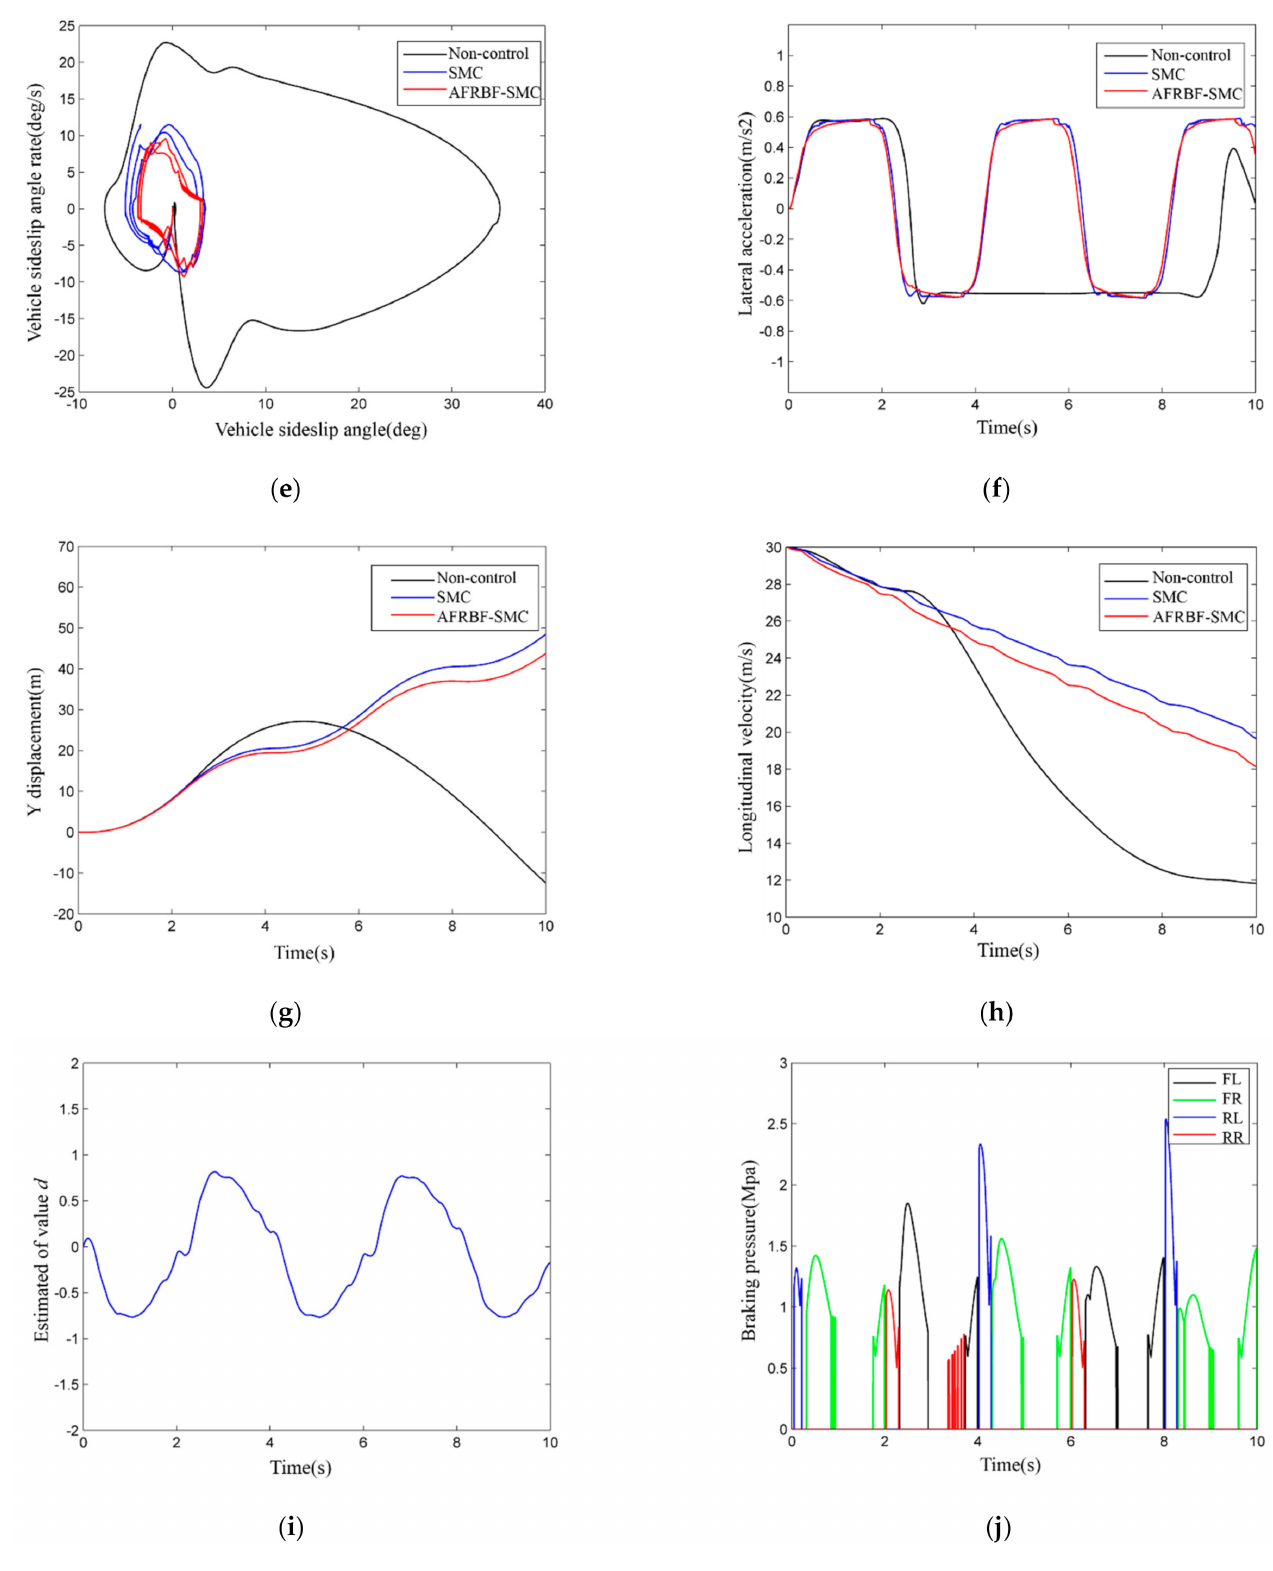
Figure 6. The simulation results of the front wheel sinusoidal steering test: ( a ) the comparison of estimated sideslip angle and real value; ( b ) the sideslip angle estimation error; ( c )the vehicle yaw rates; ( d ) the vehicle sideslip angle; ( e ) the phase plane of the vehicle sideslip angle and the vehicle sideslip angle rate; ( f ) the vehicle lateral acceleration; ( g ) the vehicle lateral displacement; ( h ) the vehicle longitudinal velocity; ( i )the estimated of value d ; ( j ) brake pressure of the braking wheels by adaptive fuzzy radial basis function neural network sliding mode control (AFRBF-SMC)